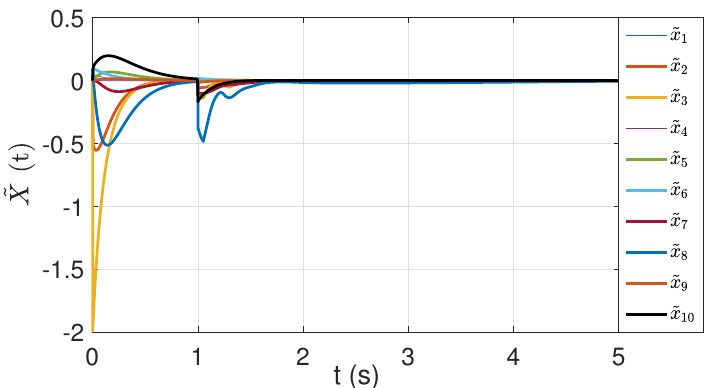
Figure 8. The state estimation error signal ˜ x has a peak at the instant at 1 s, indicating that the attack was deployed. This peak value is used to estimate the proper α for ˆ τ estimation.